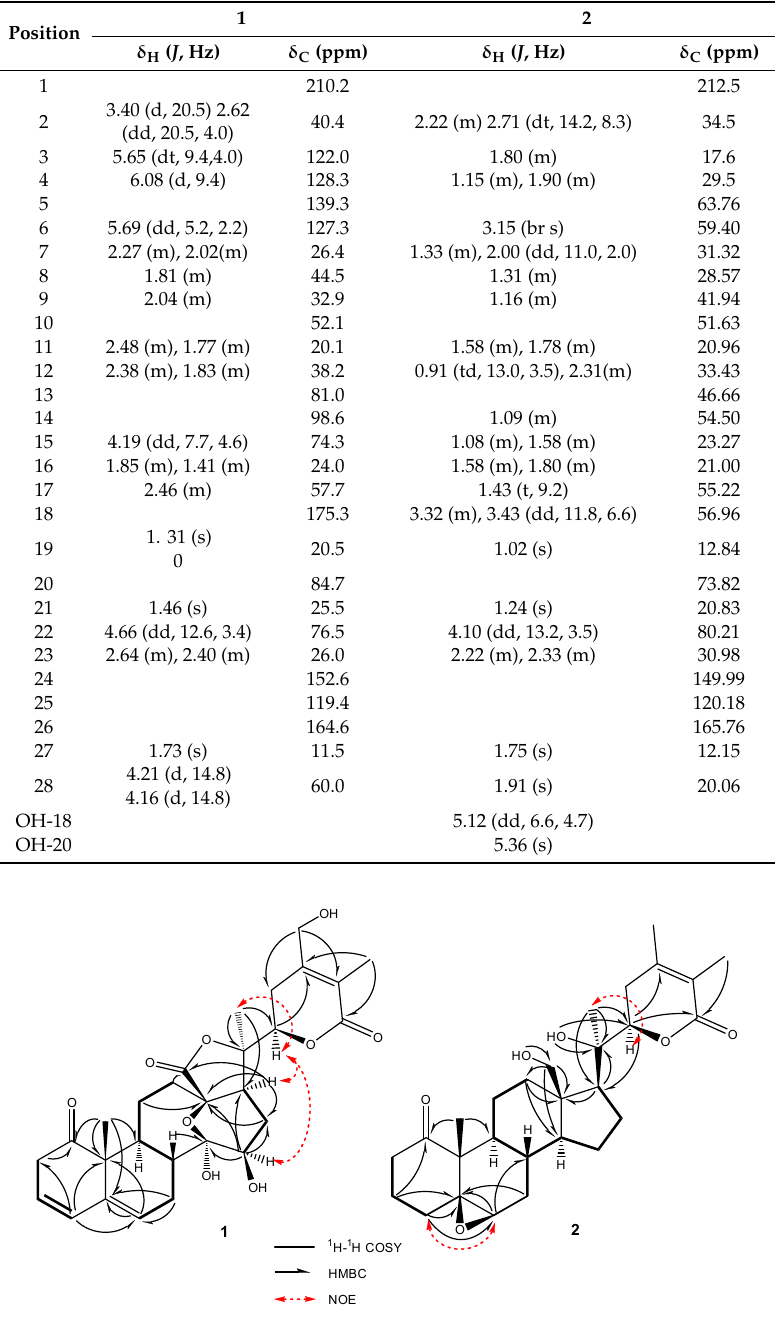
Figure 3. Calculated and experimental ECD spectra for 1 and 2 in MeOH.